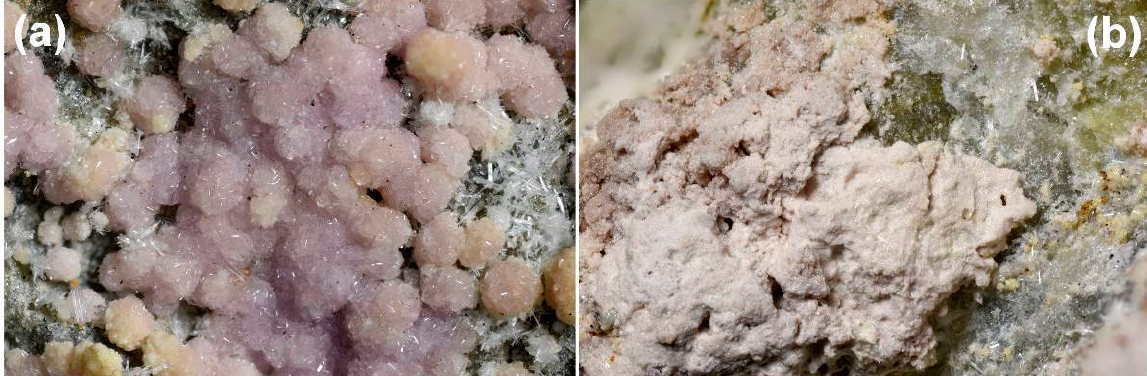
Figure 27. The two iron phosphate-sulfates occurring at the Buca della Vena mine. ( a ) Bohuslavite, as rounded aggregates of tabular pseudohexagonal crystals, up to 1 mm in size, with gypsum as colorless needles. ( b ) Destinezite, as microcrystalline pinkish masses, up to 3 mm in size. Destinezite occurs at the Buca della Vena mine as microcrystalline whitish to pinkish aggregates (Figure 27b), in the same occurrence of bohuslavite. Its identification was performed